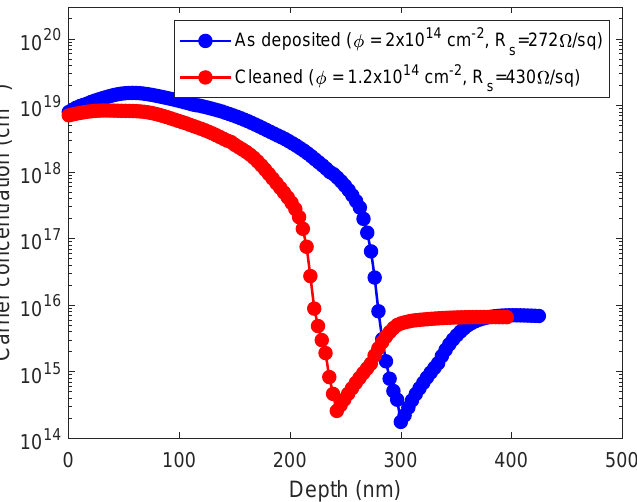
Figure 7. Carrier concentration profile of the as-deposited (blue line) and cleaned (red line) samples with 150 min deposition in a 10% concentrated